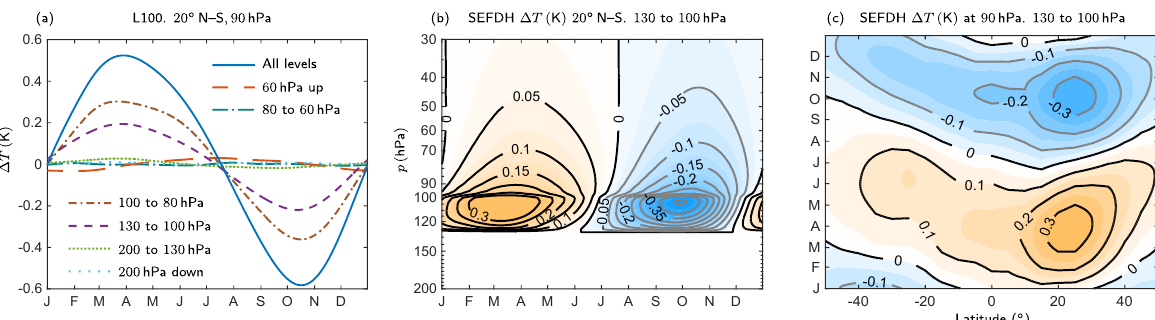
Figure 6. Annual cycle temperature changes (K) at 90hPa calculated using SEFDH with the annual cycle in water vapour imposed within different pressure ranges. Outside of this range and on the pressure level at the lower bound (in terms of height) of the range, the water vapour mixing ratio is kept at the annual mean value. The plots are averaged between 20 ◦ N and 20 ◦ S. The contributions from each layer add up linearly to reproduce the total change (not shown). The temperature change (K) for the case in (a) where the annual water vapour cycle is imposed only from 100 to 130hPa is shown in (b) averaged between 20 ◦ N and 20 ◦ S and in (c) at